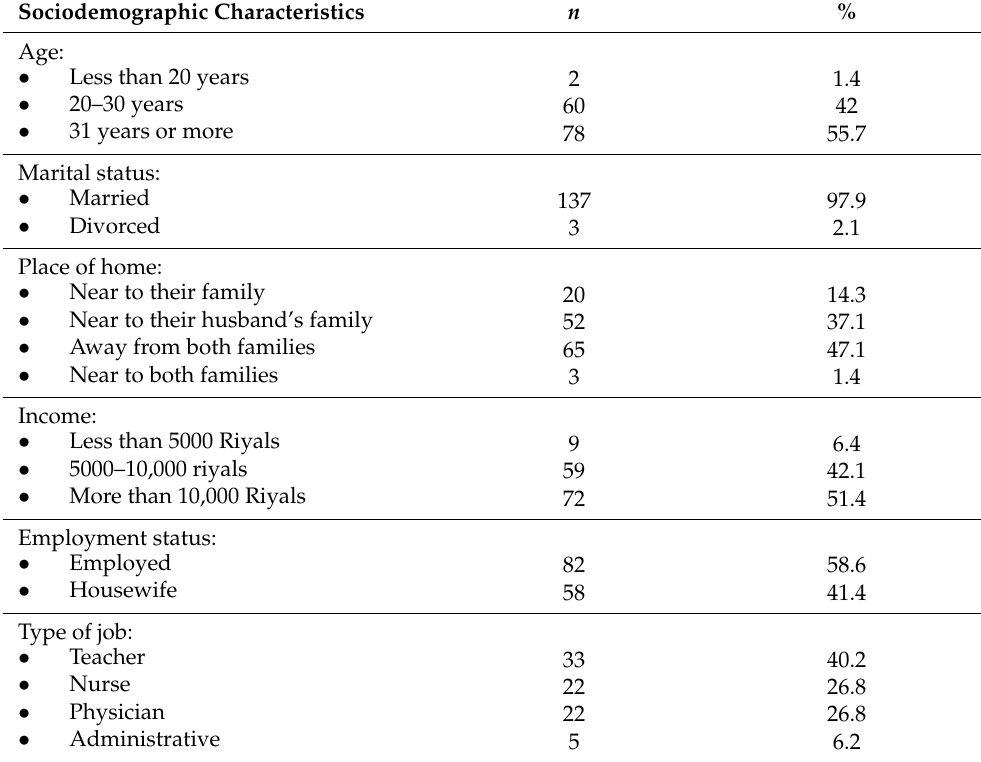
Table 1. Sociodemographic characteristics of the study